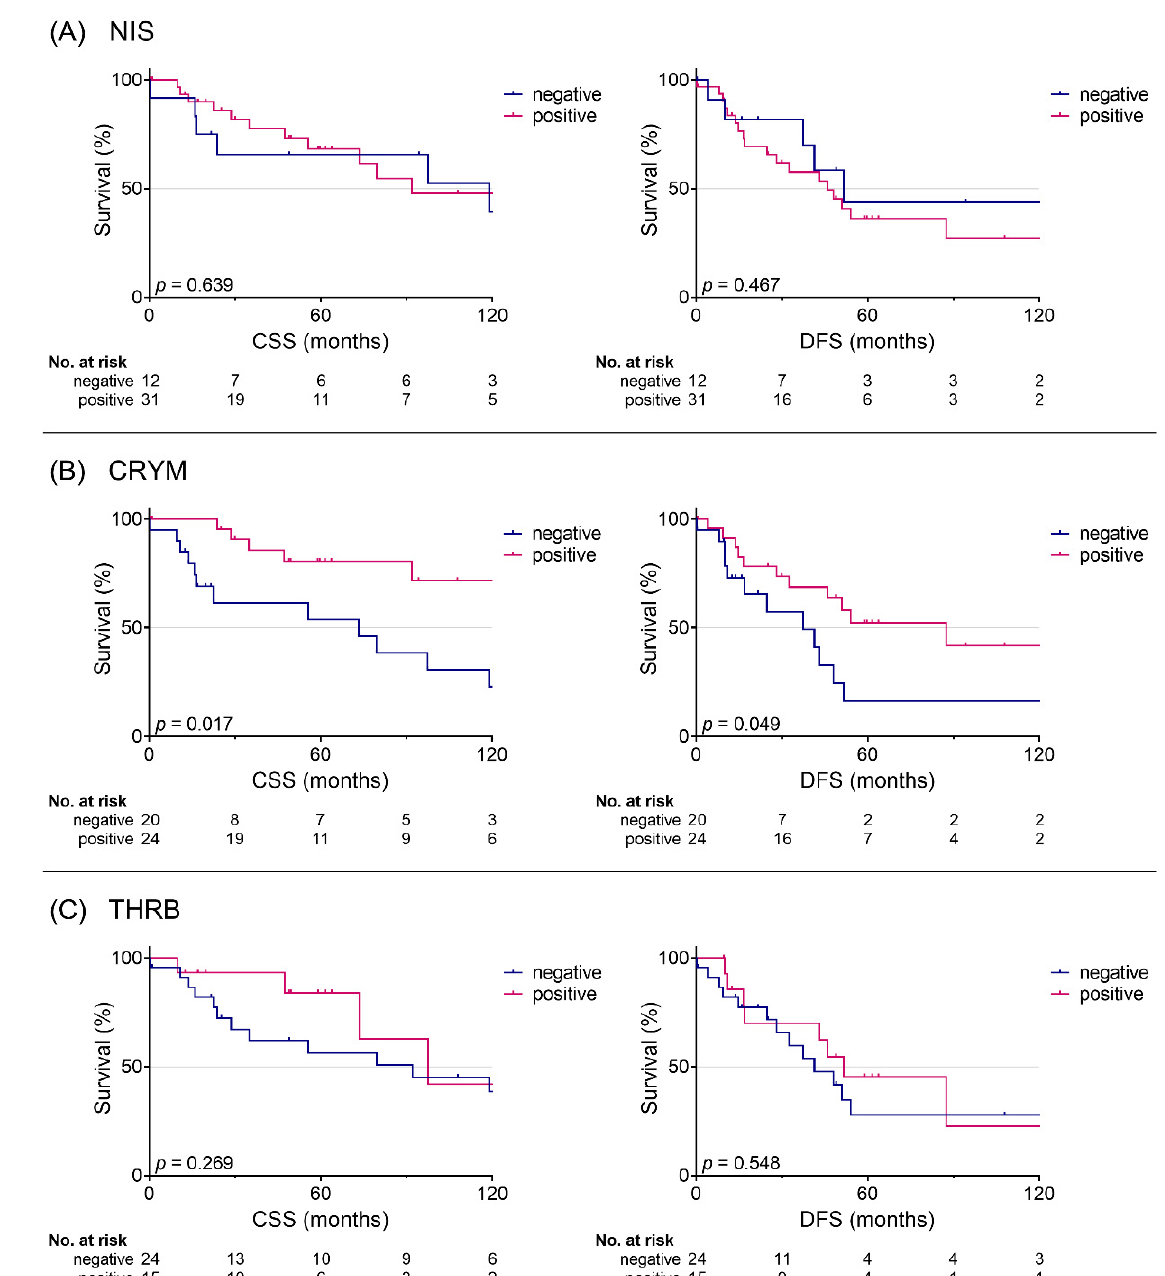
Figure 2. Kaplan–Meier survival curves. CSS and DFS for positive and negative protein levels of NIS ( A ), CRYM ( B ), and THRB ( C ). CSS: cause-specific survival; DFS: disease-free survival; p : log-rank p -value.